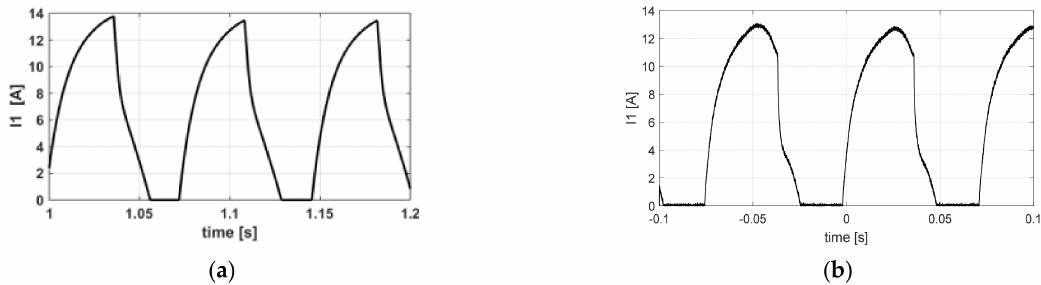
Figure 17. The waveforms of the coil current (I1) for no-load at 36 V supply: ( a ) simulation results; ( b ) test results.